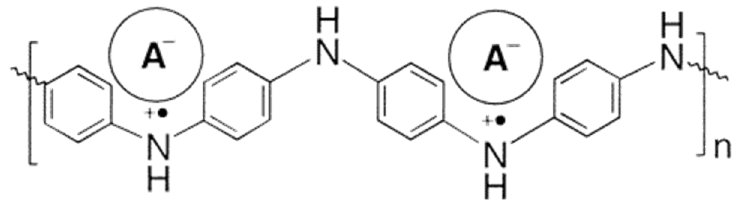
Figure 6. Molecular Structure of PANI(DEPSA)0.5. Reproduced with the permission of Reference [8]. Copyright 2002 American Chemical Society.